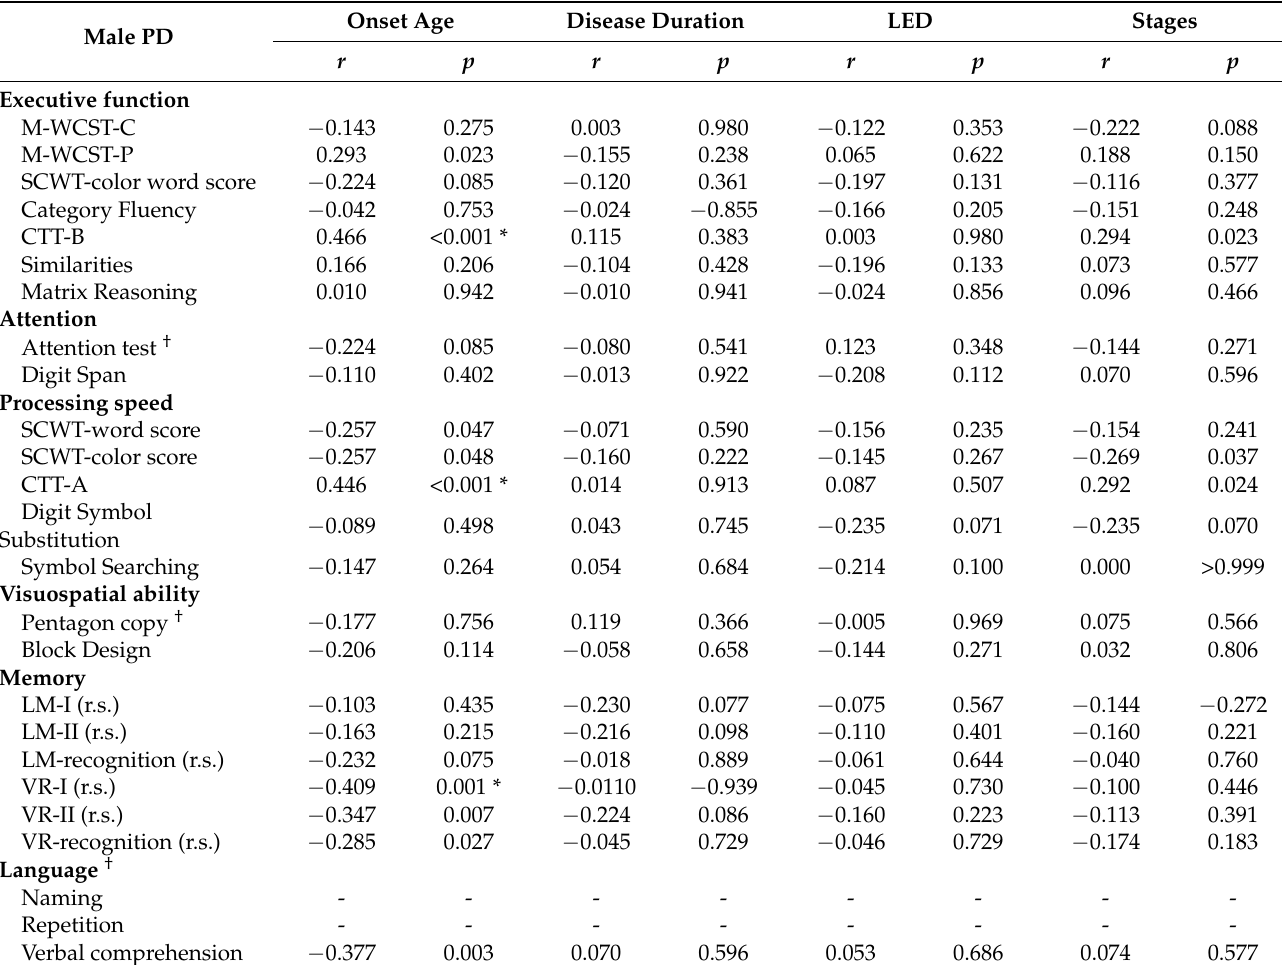
Table 4. Correlations between the clinical characteristics and the neurocognitive performances in male PD.